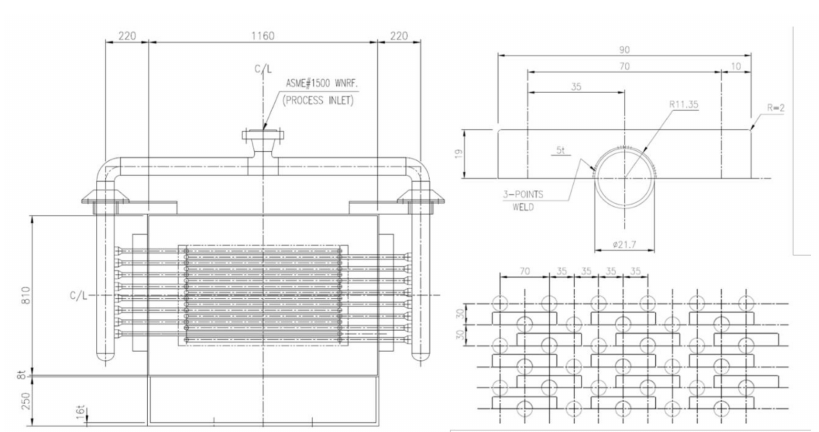
Figure 1. Schematic of the SCO 2 heat exchanger tube bundle.